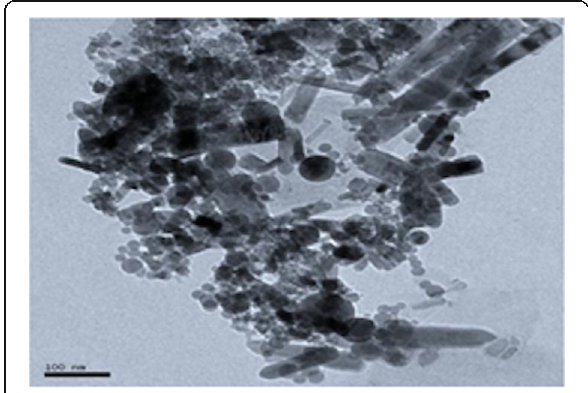
Fig. 1 Typical TEM image of ZnO + TiO 2 nanoparticles where the nano-rods are ZnO and the nano-spheres are TiO